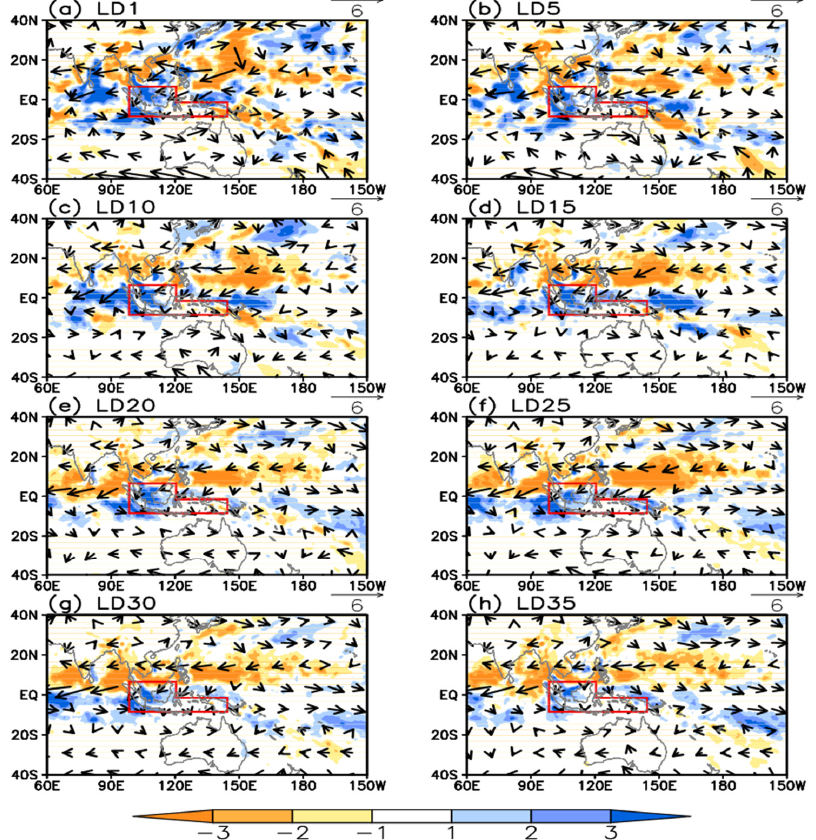
Figure 12. Differences in rainfall (shaded areas; mm/day) and 850-hPa winds (vectors; m/s) between 60th–61st pentad mean and 57th–58th pentad mean for CFSv2 predictions in ( a ) LD1; ( b ) LD5; ( c ) LD10;